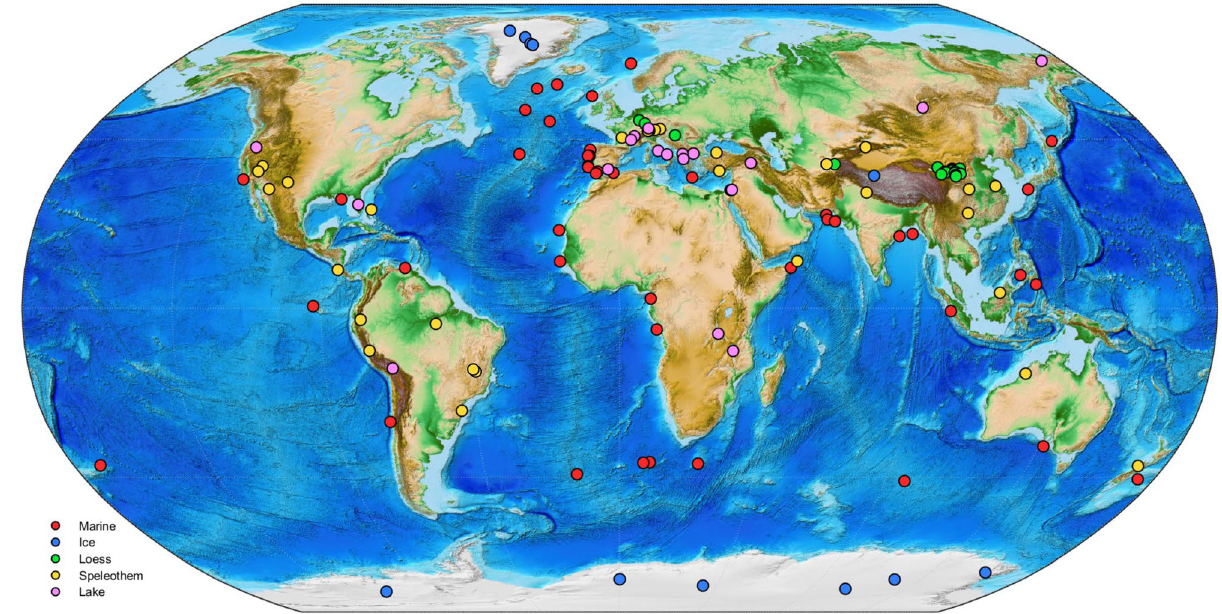
Figure 1. Map of the records included in the PaleoJump database and listed in the Supplementary Information. The five record sources—marine sediments, ice cores, terrestrial deposits, speleothems, and lake sediments—are identified in the legend by color. The land topography and ocean bathymetry are based on the ETOPO1 Global Relief Model data 175